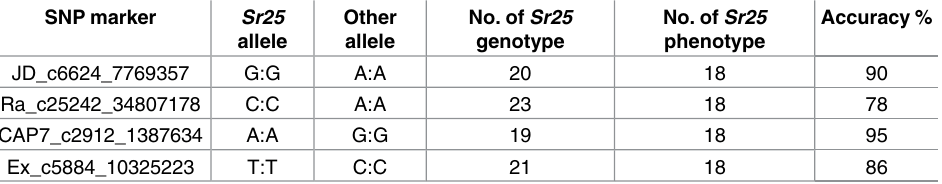
Table 4. Validation of SNP markers linked to Sr25 in wheat breeding lines with known gene resources. SNP marker Sr25